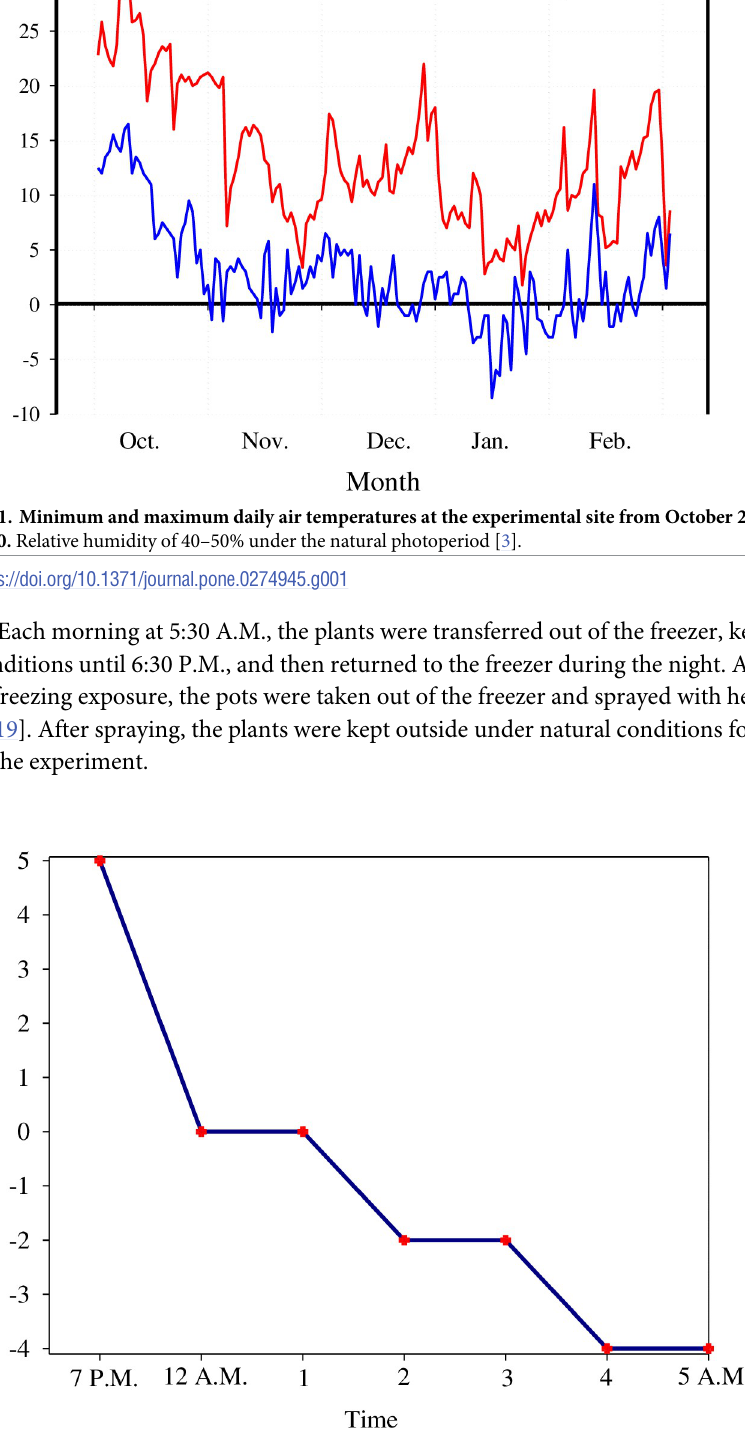
Fig 2. Trend of temperature decrease in thermogradient freezer during the night from 7:00 P.M. to 5:00 A.M.